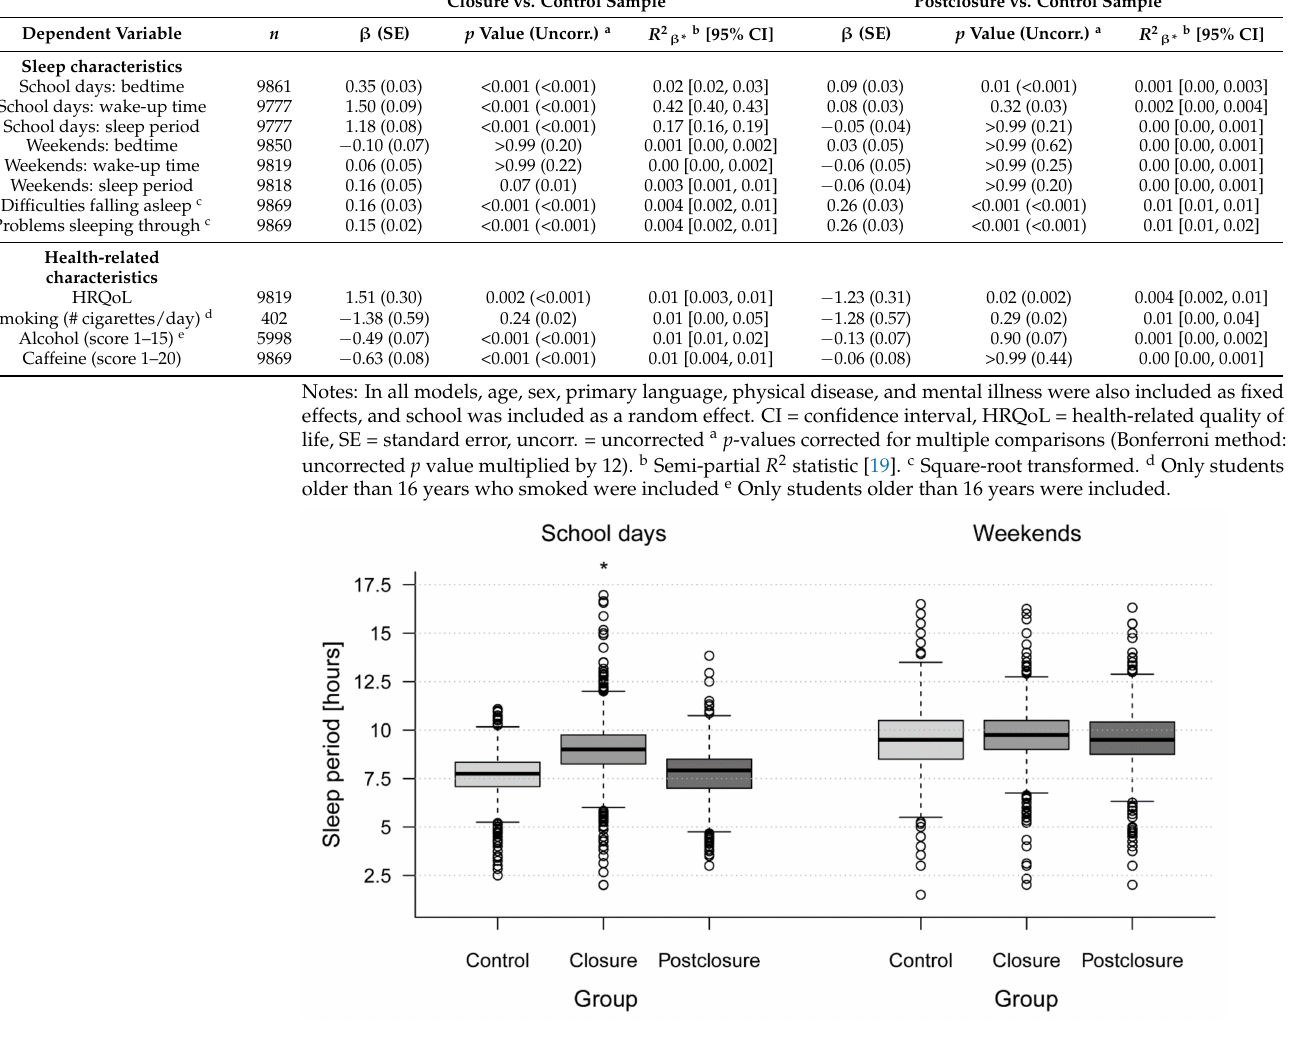
Figure 1. Sleep period on school days and weekends across all three groups (control group assessed under regular conditions in Spring 2017, closure group assessed during pandemic high school closures in Spring 2020, postclosure group assessed under pandemic conditions but schools were open in Spring 2021). * Mixed models were used to investigate differences between the control group (reference category) and the pandemic samples (closure and postclosure group) while controlling for sociodemographic variables and school (random effect), separately for sleep period on school days and on weekends. Sleep period on school days was significantly longer in the closure compared to the control group ( p < 0.001). No significant difference between the postclosure and control group’s sleep period on school days was found and the groups showed similar sleep periods on